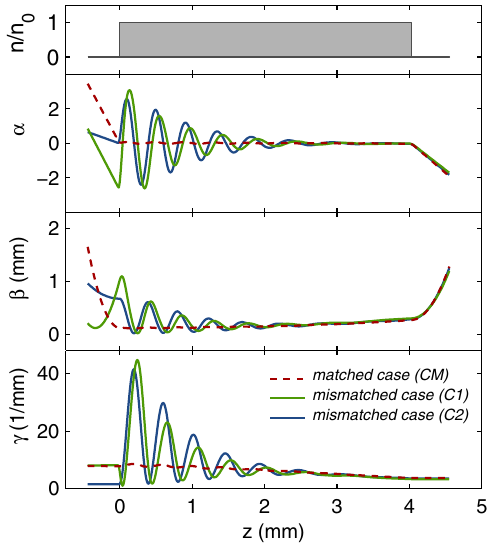
FIG. 2. Plasma density profile and evolution of the